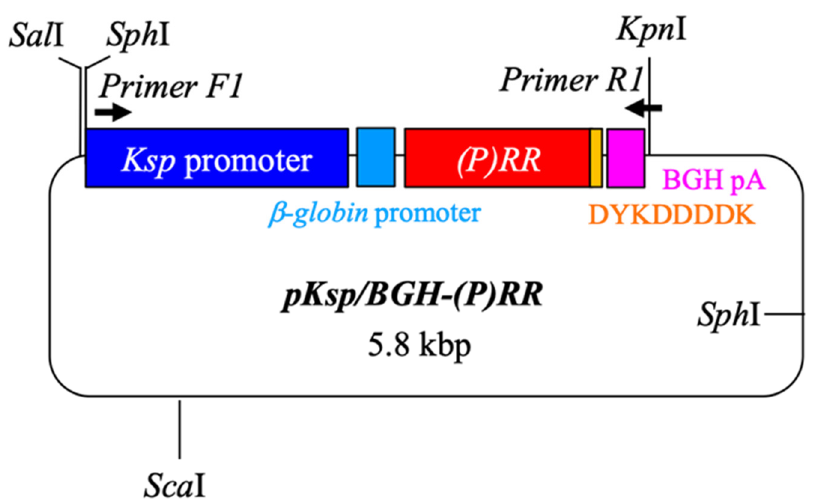
Figure 12. Construct of